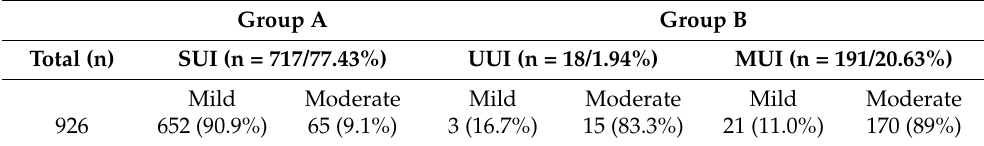
Table 1. UI type